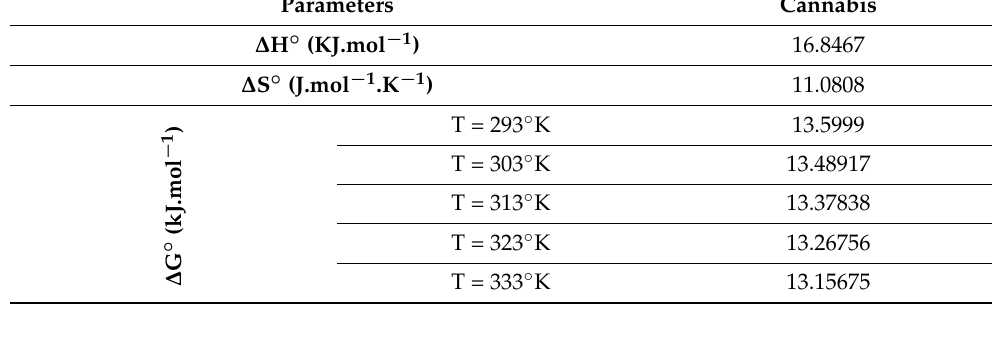
Table 5. Thermodynamics parameters data of EBT dye adsorption on activated carbon of cannabis. Parameters